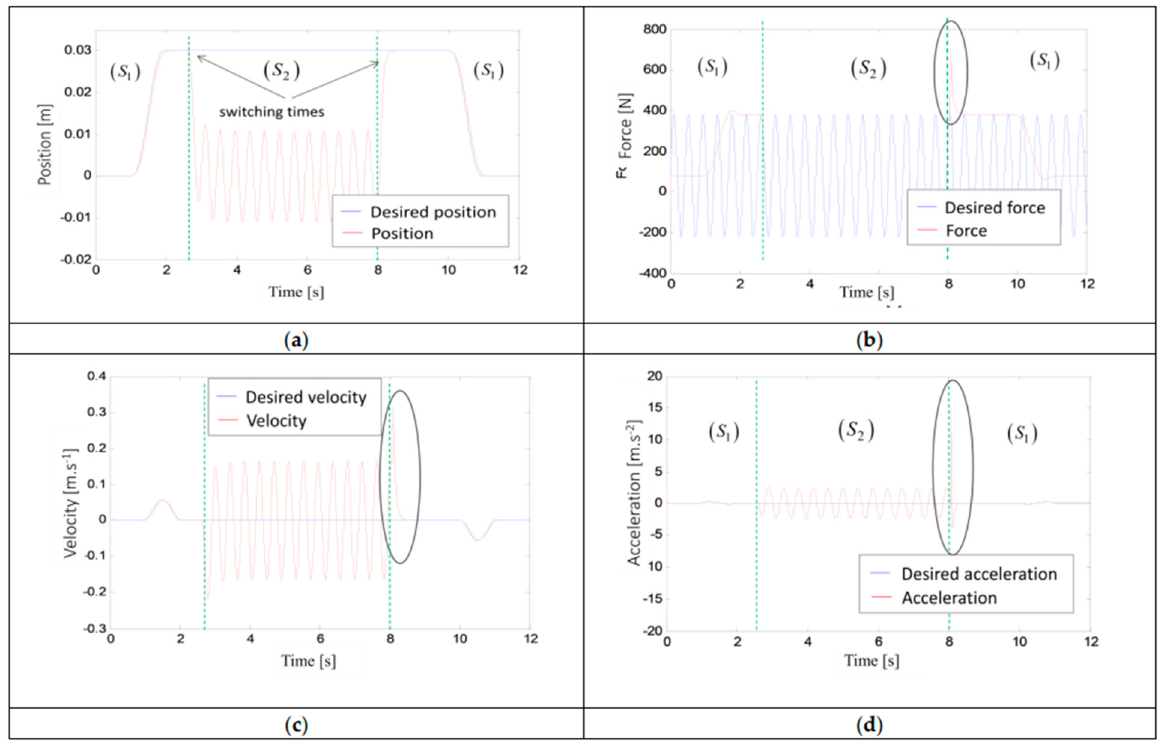
Figure 3. Illustration of the switching problem: ( a ) evolution of position (red) and its desired tra- jectory (blue); ( b ) evolution of force (red) and its desired trajectory (blue); ( c ) evolution of velocity (red) and its desired trajectory (blue); ( d ) evolution of acceleration (red) and its desired trajectory (blue).